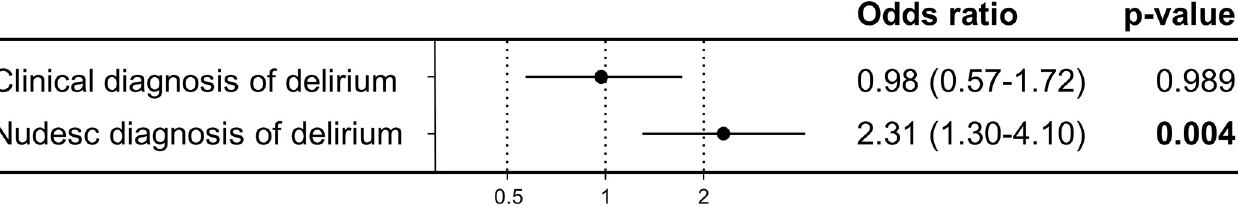
Fig 3. Multivariable binary logistic regression analyses for ICU mortality. Odds ratios adjusted for age, mechanical ventilation, severe shock, acute kidney injury and SAPS 2 � 50.